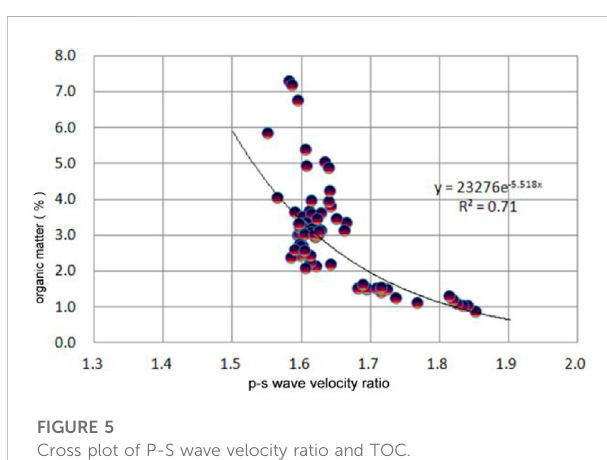
FIGURE 5 Cross plot of P-S wave velocity ratio and